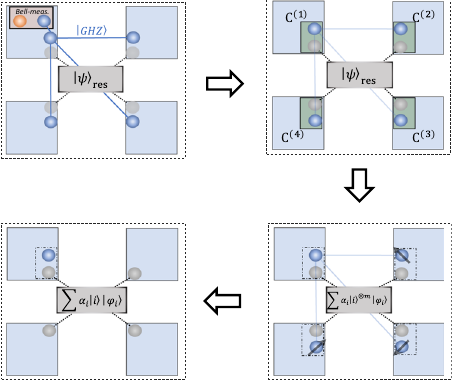
Fig. 1 Problem setting. Schematic illustration of the overall process for a four-device quantum network. Upper-left device acts as initiator. Each gray vertex represents all the resource and auxiliary qubits that each device owns. First (upper-left), the initiator device prepares the weight state of Eq. (10), which corresponds to the orange vertex. Further, we require that the four quantum network devices share a fi ve qudit GHZ-state, see Eq. (11), which comprises the blue vertices. After the Bell-measurement, the four quantum network devices share the state ψ R j i of Eq. (12). In second place (upper-right), each device applies the corresponding controlled unitaries, using the request state ψ R j i and their auxiliary qubits ψ j i , to the resource state of the network ψ j i in a coherent way. Q aux res m (cid:4) 1 C ð i Þ The maps C ( i ) are de fi ned as C ð i Þ ¼ , i.e., the product of all k ¼ 0 k controlled unitaries for one particular network device. In this way, the desired coherent superposition is generated (bottom-right). Finally, all control registers, except the initiator one, are measured and the desired superposed state (up to corrections) of Eq. (16) is generated